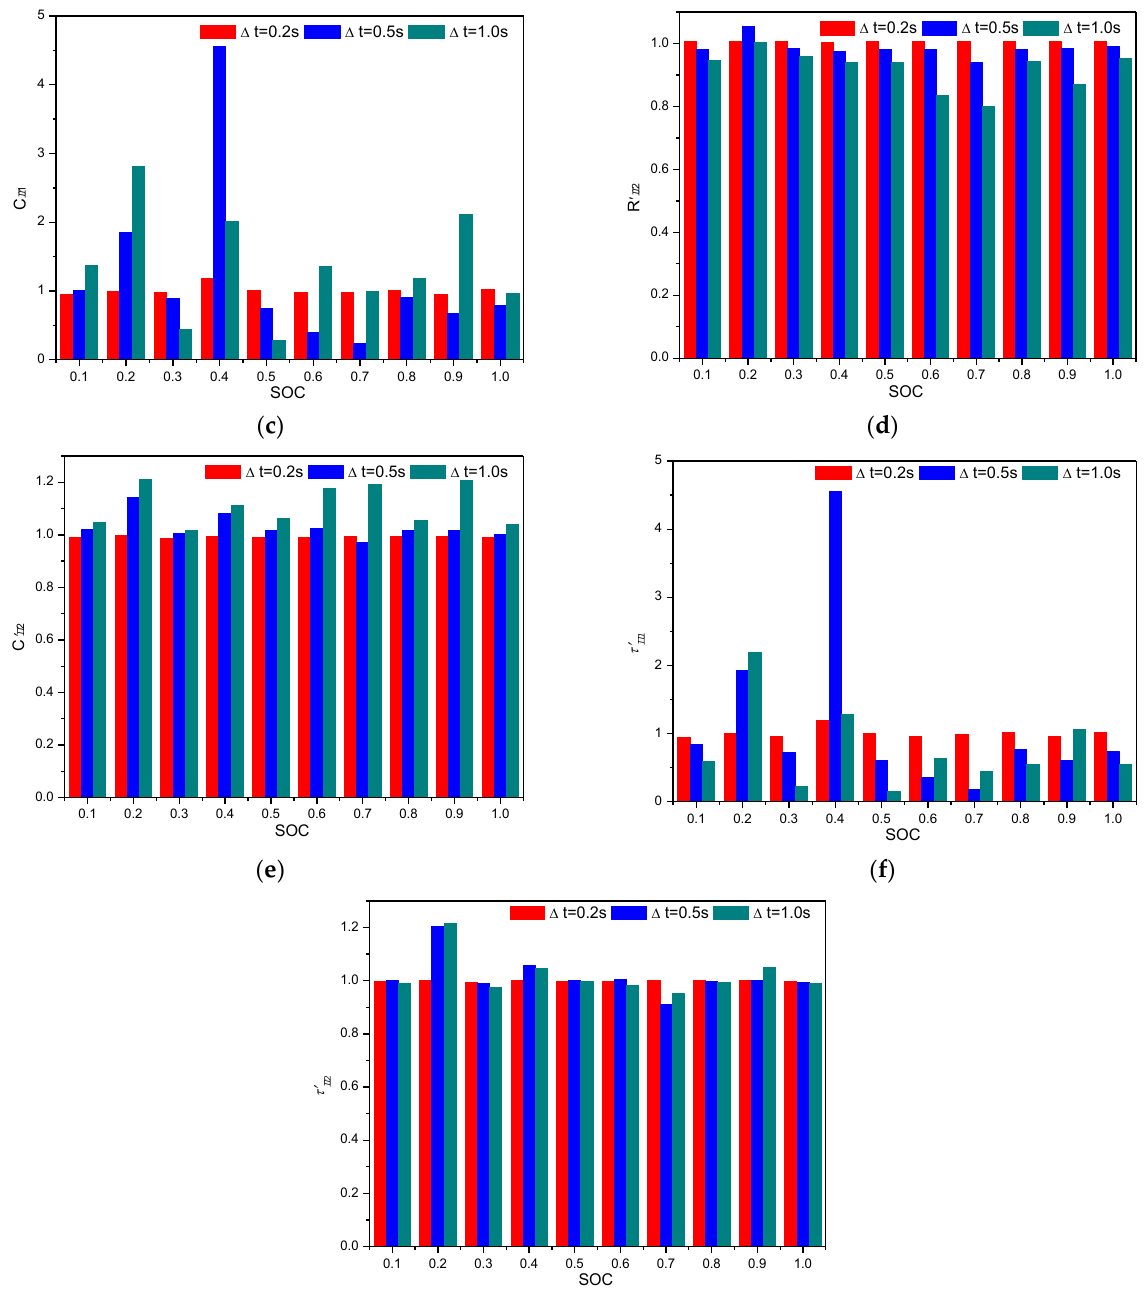
Figure 14. Change curves of non-dimensional parameters with SOC of 2-RC circuit model: ( a ) R ’ II0 ; ( b ) R’ II1 ; ( c ) C’ II1 ; ( d ) R’ II2 ; ( e ) C’ II2 ; ( f ) τ ’ II1 ; ( g ) τ ’ II2